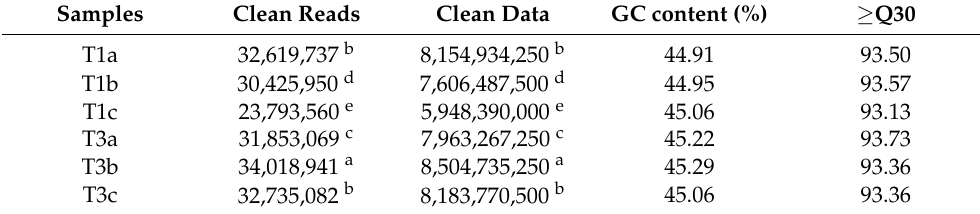
Table 1. Summary of the tested chestnut transcriptome sequencing dataset.